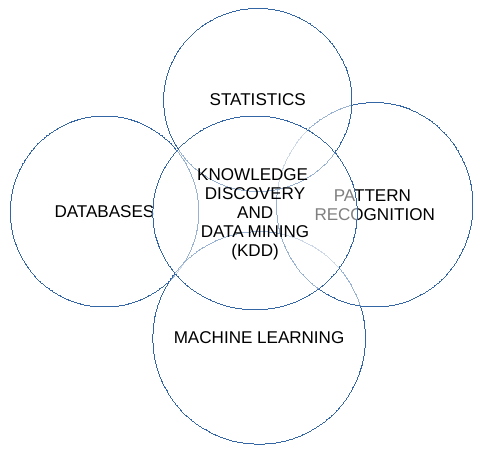
Figure 1: Multi-disciplinary nature of knowledge discovery and data mining (KDD) and data science in